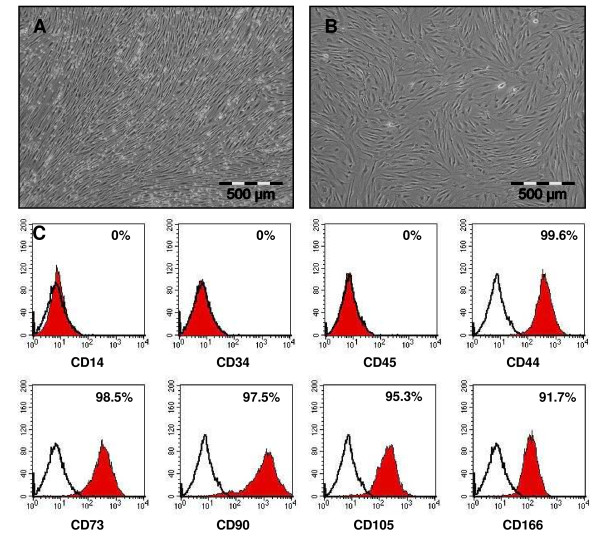
Morphology and surface marker presentation of human MSC (A-C). Human mesenchymal stem cells (MSC) were isolated from bone marrow aspirates. During primary culture (A) and up to passage 3 (B) they showed a typical fibroblast-like morphology and grew in a swirling-like pattern. Flow cytometry analysis demonstrated a homogenous MSC population (C). As expected, MSC were negative for reactivity to antigens CD14, CD34 and CD45, but positive for reactivity to antigens CD44, CD73, CD90, CD105 and CD166.